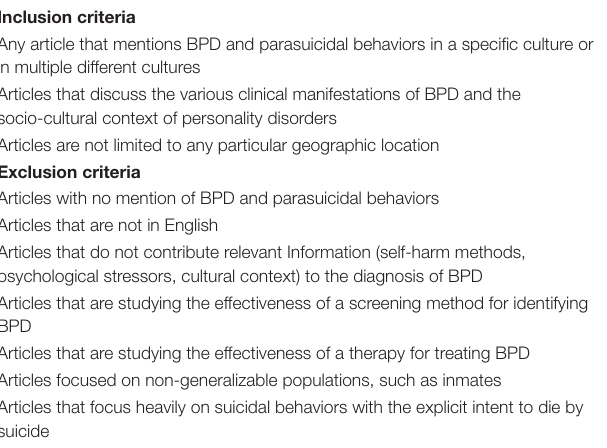
Frontiers in Sociology |